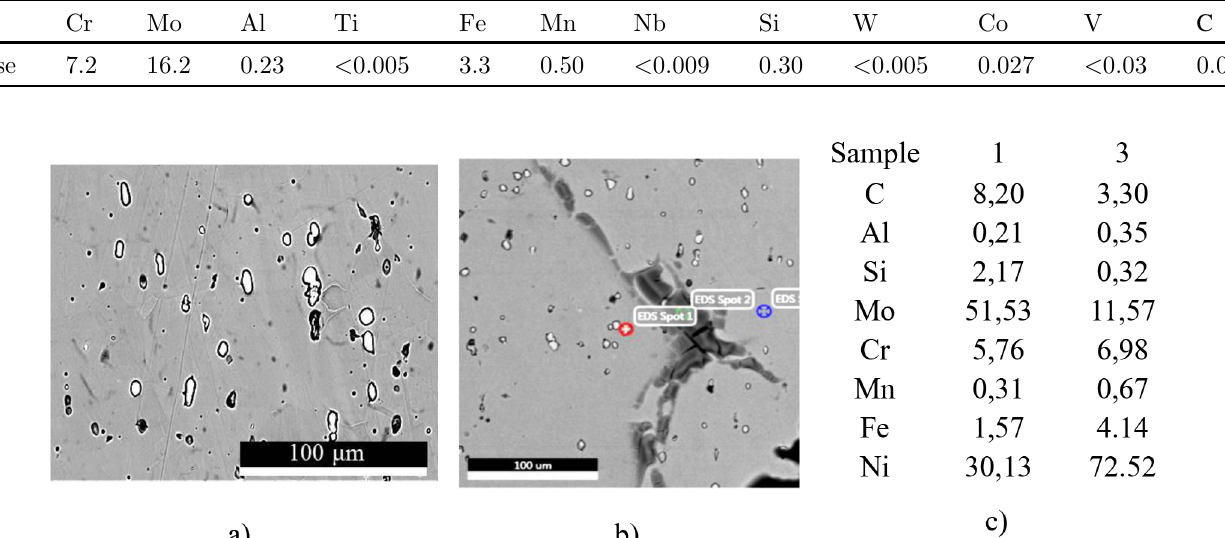
Fig. 3. Metallographic structure of the Hastelloy-N alloy before exposure: (a) the center of the specimen surface; (b) the cross section of several grains; (c) composition of the grains and the particulate inclusions (in mass %).